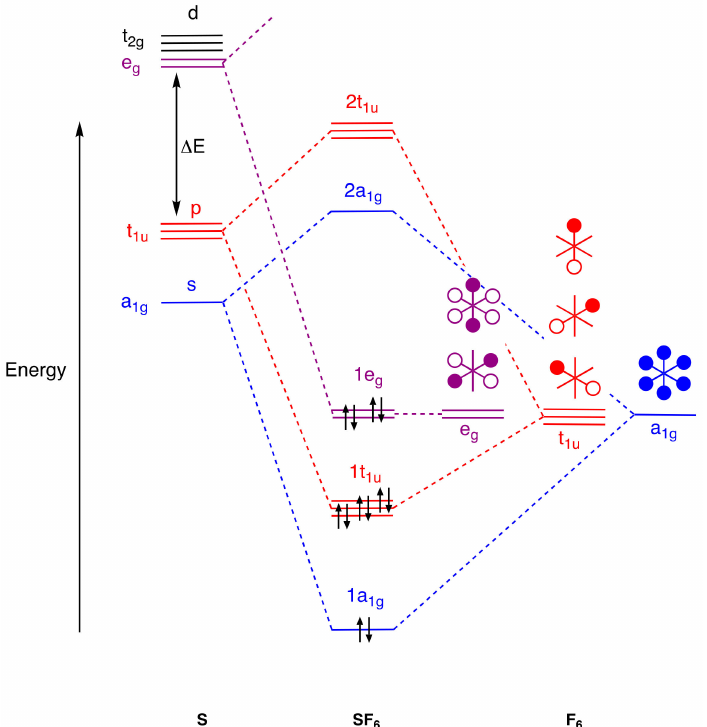
Figure 2. A simple, qualitative, σ -only MO energy-level diagram for SF 6 . Orbital interactions involving sulphur 3s (a 1g ) and 3p (t 1u ) orbitals with their symmetry-equivalent fluorine-based counterparts are shown in blue and red. The potential interactions of e g symmetry involving the sulphur 3d orbitals are indicated in purple. No symmetry match is possible for the sulfur 3d t 2g